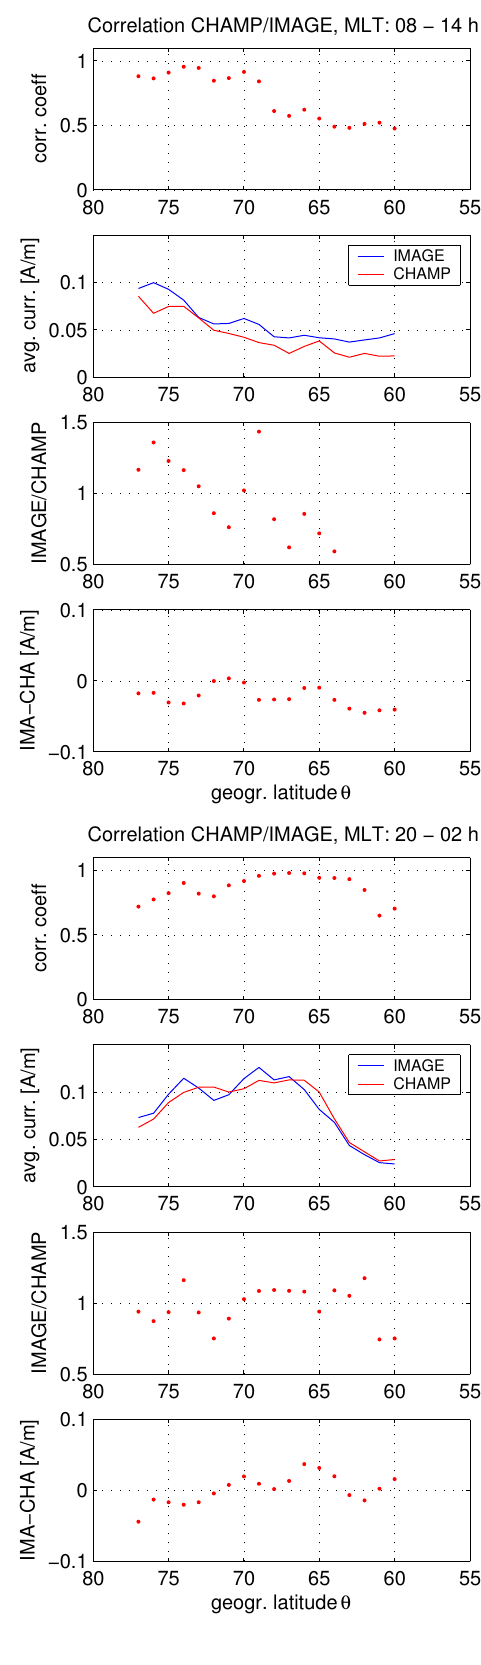
Fig. 11. Correlation analysis of the CHAMP versus IMAGE current, estimates grouped in 4 magnetic local time sectors.